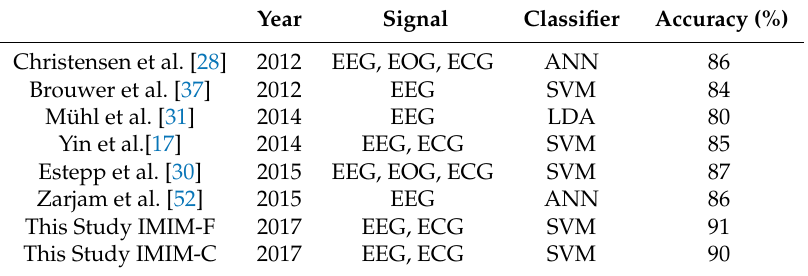
Table 6. Comparison of different mental workload estimation methods in recent